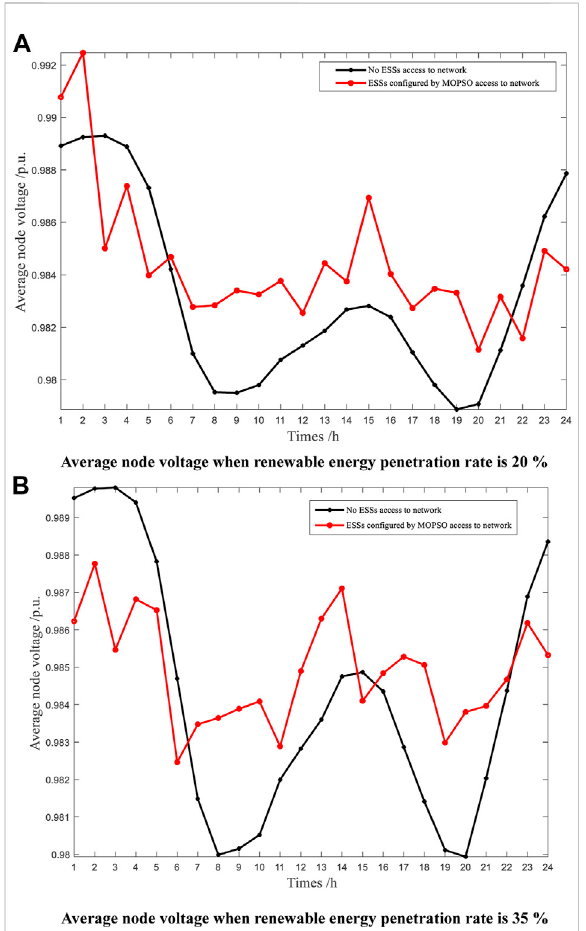
FIGURE 7 Average node voltage after optimized con fi guration of ESSs when renewable energy penetration is 20% and 35%. (A) Average node voltage when renewable energy penetration rate is 20 %; (B) Average node voltage when renewable energy penetration rate is 35 %.